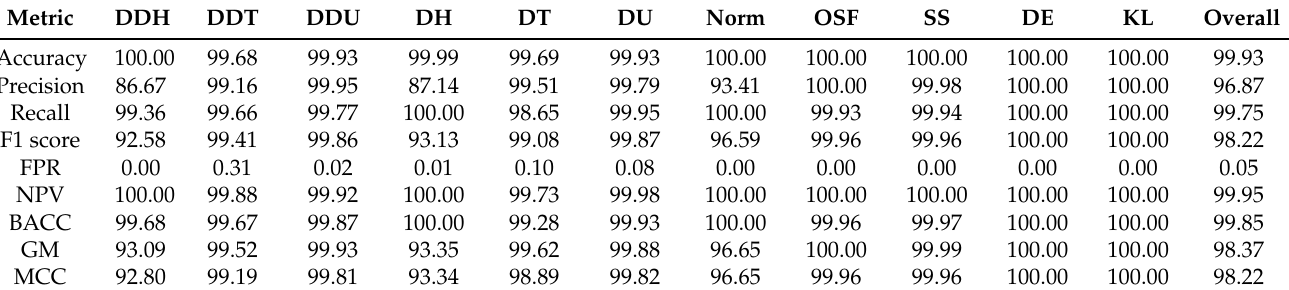
Table 7. Classification performance of LS-DRNN model.